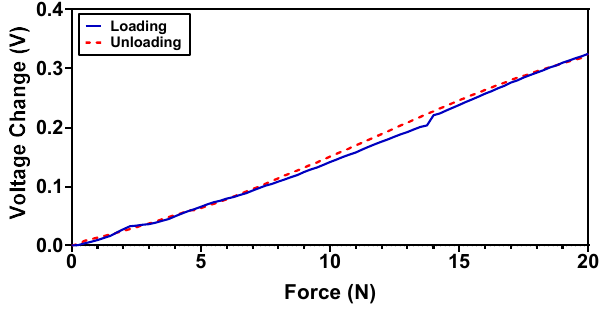
Figure 18. Hysteresis of the proposed magnetic tactile sensor in the normal direction.